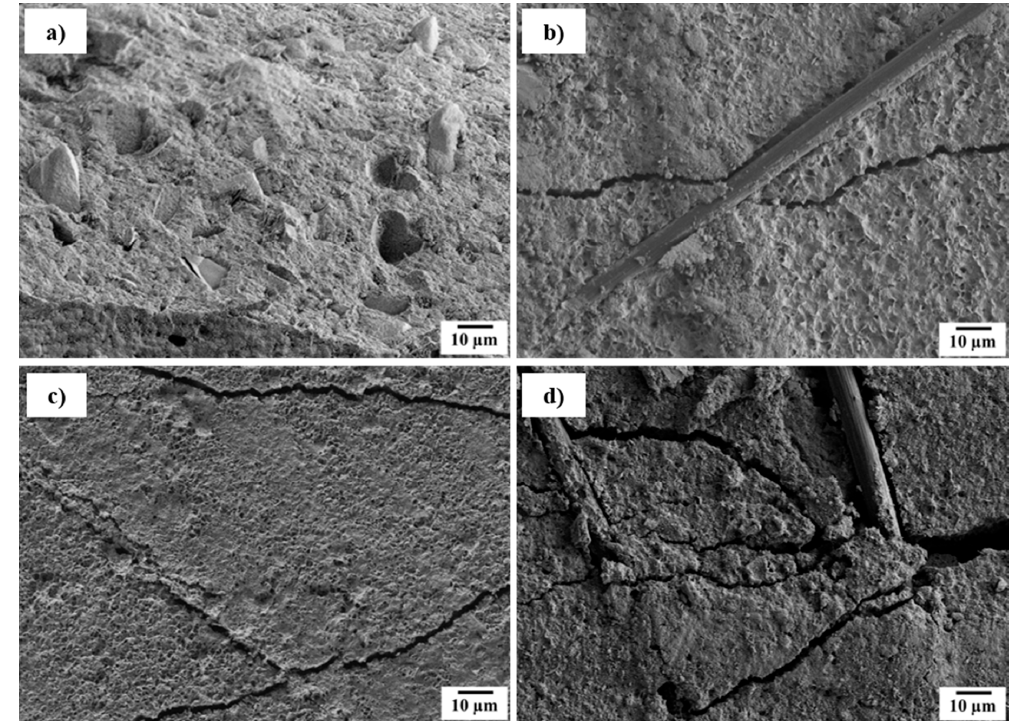
Figure 5. Scanning electron microscopy of ( a ) the fracture plane for pure calcium phosphate cement (CPC), and crack propagation at 1% strain for: ( b ) untreated; ( c ) H 2 O 2 -treated and ( d ) aqua regia - and CaCl 2 -treated fiber-reinforced CPC with a fiber content of 1 wt %.